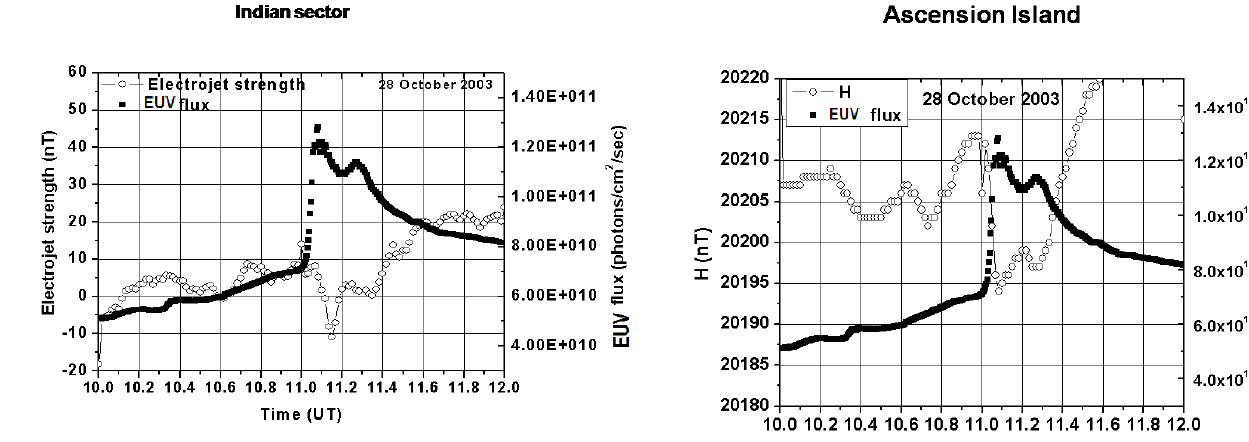
Fig. 6a. The time variations of EUV flux and electrojet strength at the station of Trivandrum (77 ◦ E) on 28 October 2003.